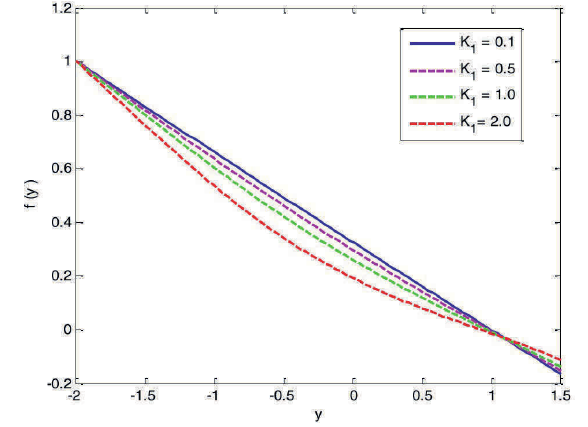
Fig. 18: Impact of homogeneous reaction parameter K 1 on concen- tration.